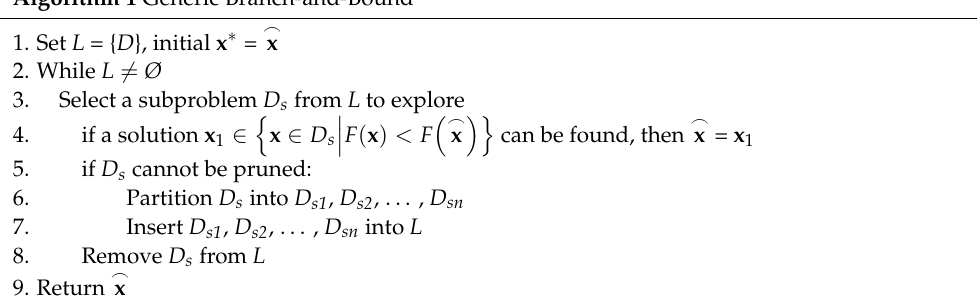
Algorithm 1 Generic